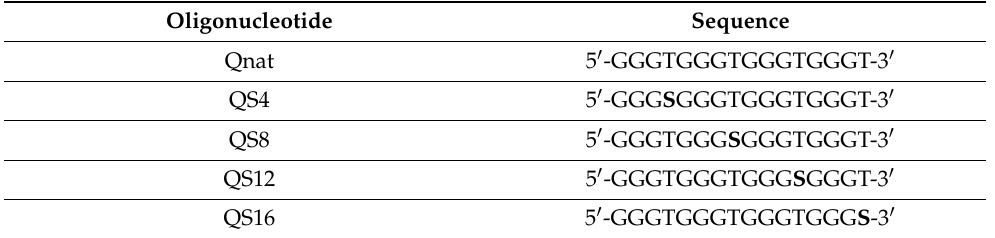
Figure 1. Schematic structure of the parallel-stranded dimeric G-quadruplex Qnat (T30695) and chemical structure of the abasic site mimic (S). Thymidines, replaced by abasic site mimics in the modified sequences, have been labeled. Table 1. Names and sequences of Qnat (T30923) and its analogues. S indicates an abasic site